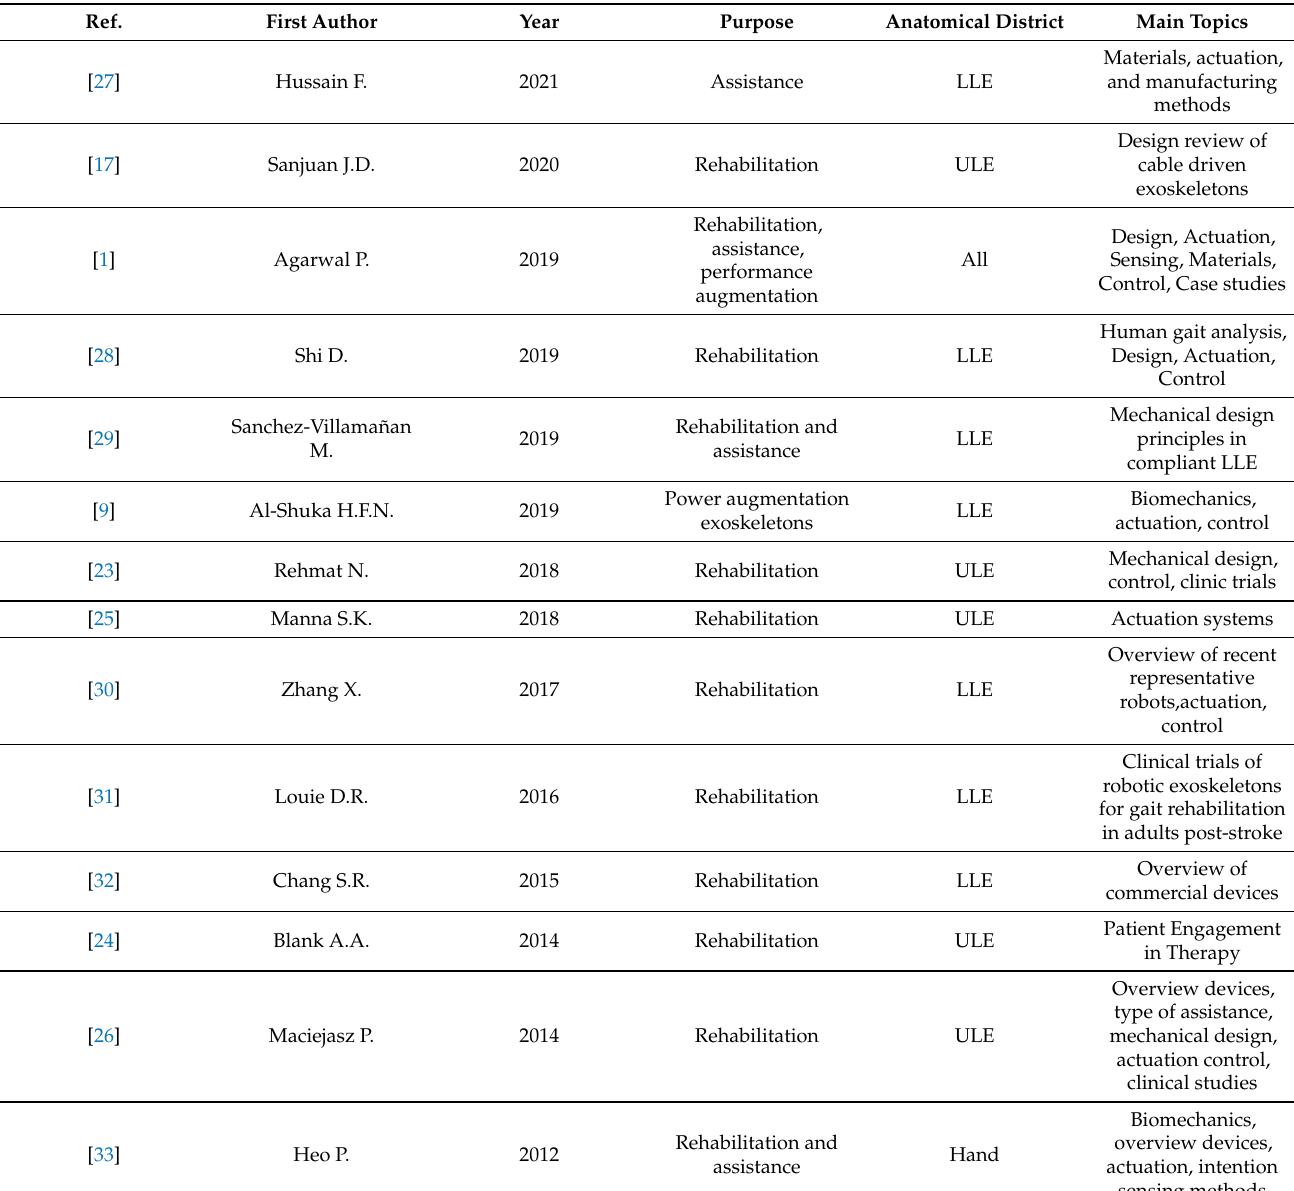
Table 1. The main reviewed publications on the exoskeleton